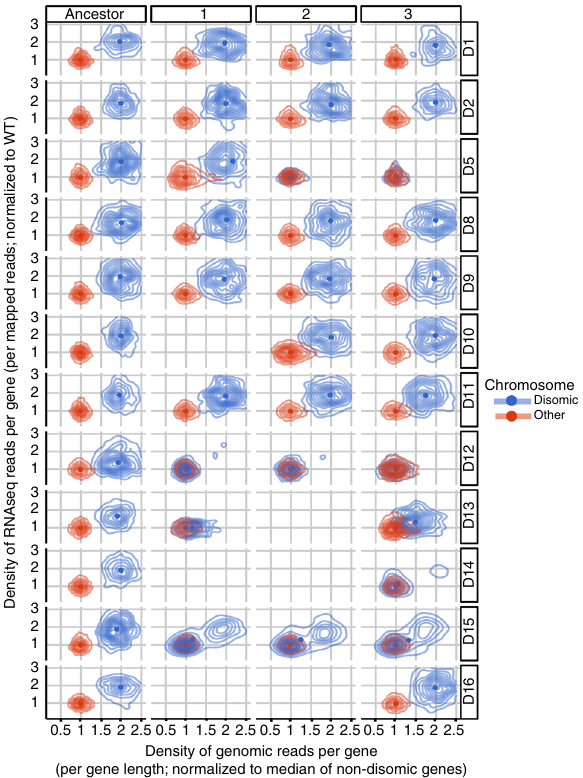
(per gene length; normalized to median of non-disomic genes) Fig. 7 Relationship between gene expression and gene copy number in disomic lines. X axis represents gene copy number, estimated by the density of genomic reads; Y axis shows the level of gene expression, estimated by the density of RNAseq reads. Contour lines are used to display the distribution of all genes in the genome, split in two groups: those located on the disomic chromosome (e.g., chromosome II for D2; shown in blue) and the rest (red). Median expression values of each group are indicated with blue or red solid dots. The panels corresponding to samples with missing genomic and/or RNAseq data were left blank.